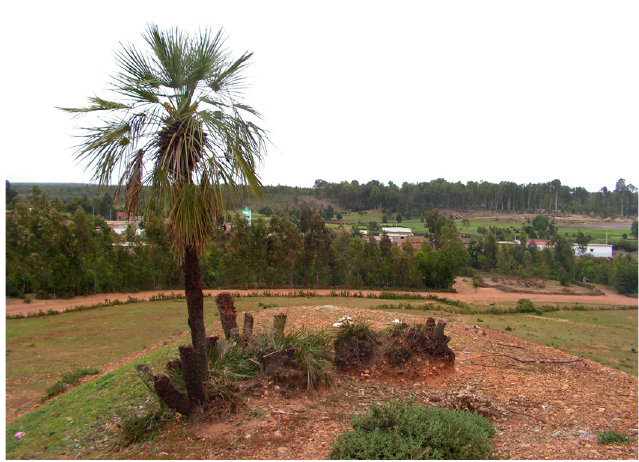
Figure 3: Degraded sacred site with arborescent form of the Dwarf Palm (Chamaerops humilis) on a dry gravel ridge (landscape section A2, NW